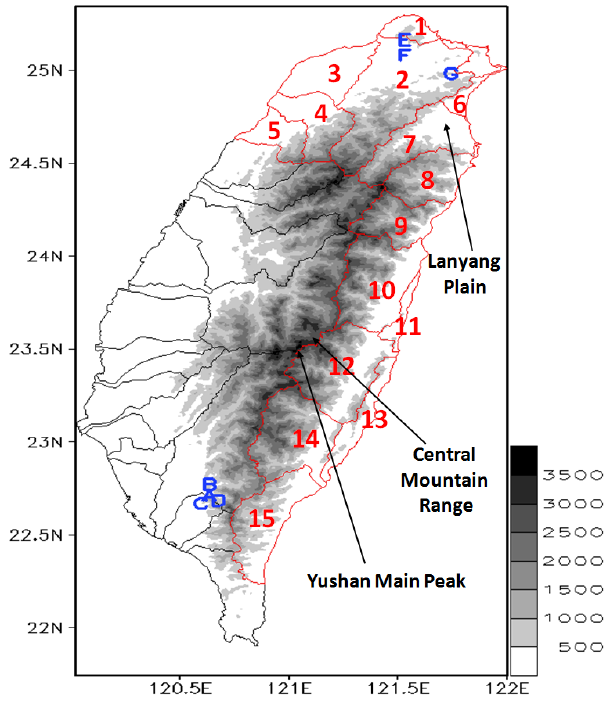
Fig 1. Topography (m, shading), river basins (region in black and red line) and the 2 Fig. 1. Topography (m, gray shading), river basins (region in black stations (mark as alphabet). The basins selected for the accompanied climatological 3 with red line) and the stations (A–G). The basins selected for the accompanied climatological rainfall model are (1) river basins rainfall model are 1: river basins of the northern coast, 2: Danshui River basin, 3: 4 of the northern coast, (2) Danshui River basin, (3) river basins river basins along the Taoyuan coast, 4: Toucian River basin, 5: river basins along the 5 along the Taoyuan coast, (4) Toucian River basin, (5) river basins Zhunan coast, 6: river basins along the Toucheng coast, 7: Lanyang river basin, 8: 6 along the Zhunan coast, (6) river basins along the Toucheng coast, (7) Lanyang river basin, (8) river basins along the Nanao coast, (9) river basins around Taroko, (10) Hualien river basin, (11) river basins along the Fengbin coast, (12) Siouguluan river basin, (13) river basins of east of the coastal mountains, (14) Beinan river basin and (15) river basins of the southern Taitung river. The stations are (A) Sandimen (C0R15), (B) Guxia (C1R11), (C) LongCyuan (C1R20), (D) Majia (C1R14), (E) Zhuzihu (01A42), (F) Wudu G: Huoshaoliao. 12 (01B03), (G) Huoshaoliao.